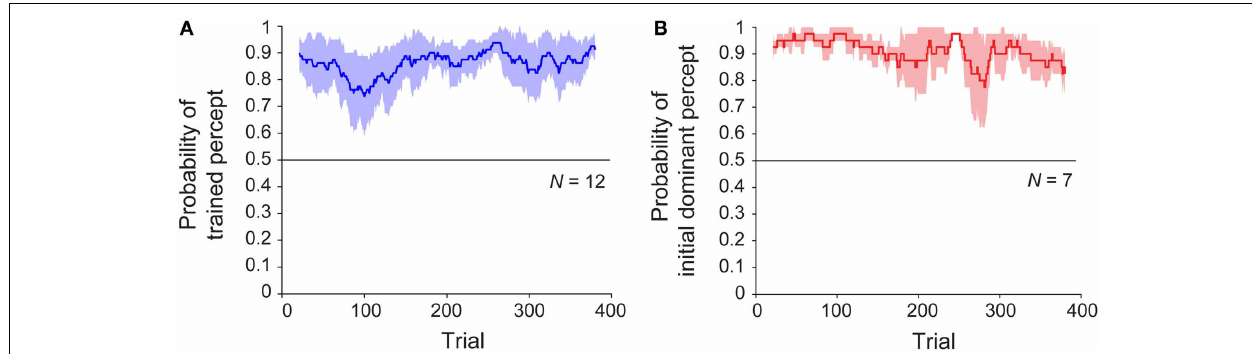
proportion of trials perceived in the “trained” direction for a sliding window of 40 trials, and shaded regions indicate median absolute